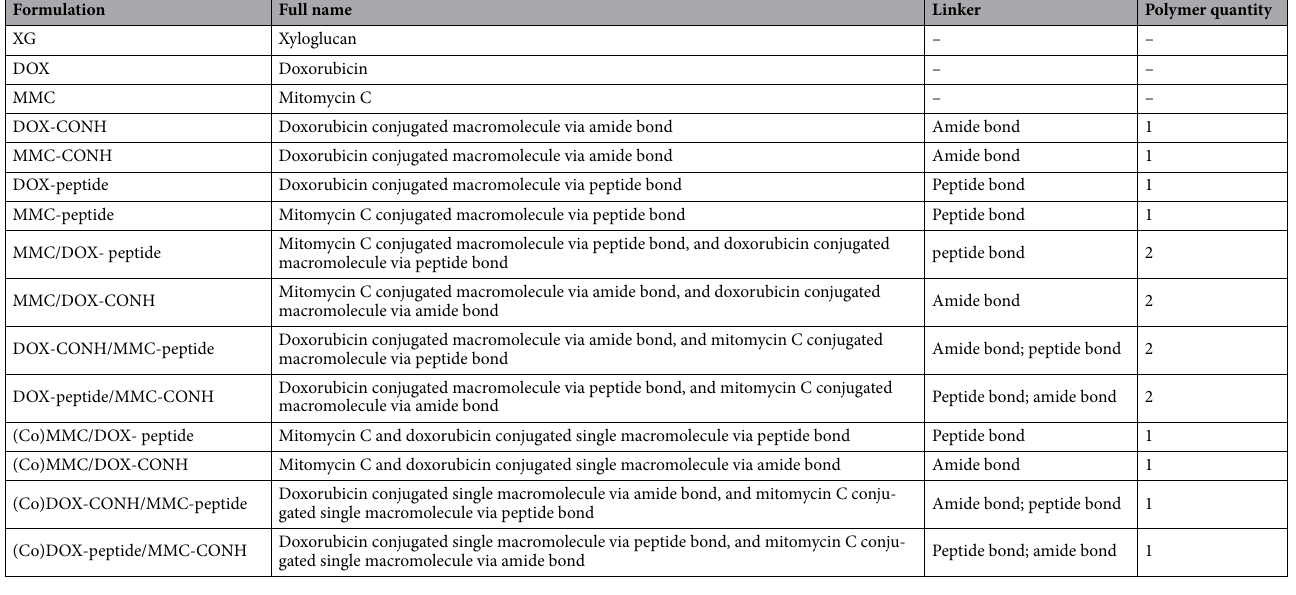
Table 1. List of abbreviations in